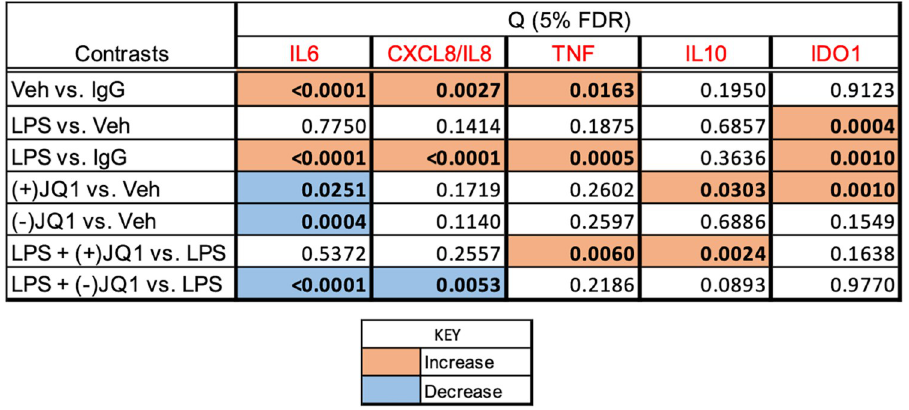
Fig 6. Heat map grid summarizing the effects of LPS, (+)-JQ and (-)-JQ1 on histone 3 acetylation at the promoters of IL6 , CXCL8/IL8 , TNF , IL10 and IDO1 . Culture and treatment conditions, chromatin immunoprecipitation (ChIP) details, and data processing are described in the Materials and methods section. The grid cells show significance values (Q) adjusted to the false discovery rate (FDR). The significance threshold is 5% FDR (Q < 0.05), highlighted in bold. The orange color indicates a significant increase, the blue color indicates a significant decrease in the acH3 ChIP signal regarding the contrasts shown. The gene symbols are in red. The Q values have been calculated by contrasting all treatments with each other (21 contrasts, listed in S5 Fig). The contrasts selected for display in the heatmap indicate LPS effects (LPS vs . Vehicle), drug effects ((+)-JQ1 or (-)-JQ1 vs . Vehicle), and drug effects on the LPS response (LPS + (+)-JQ1 or (-)-JQ1 vs .